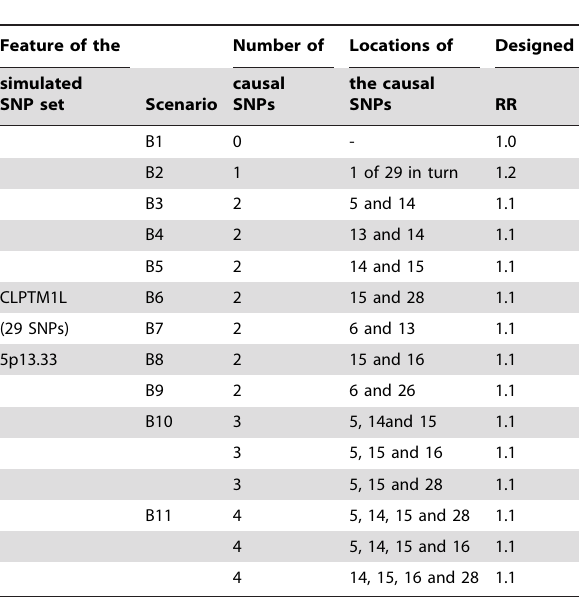
Table 2. Parameter settings based on the CLPTM1L